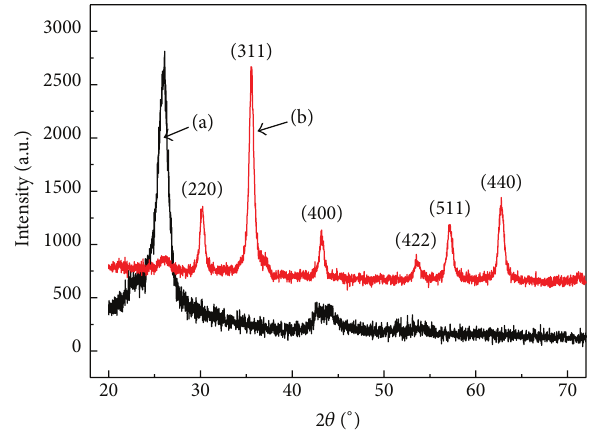
Figure 3: X-ray diffraction spectra of O-MWNTs and Fe 3 O 4